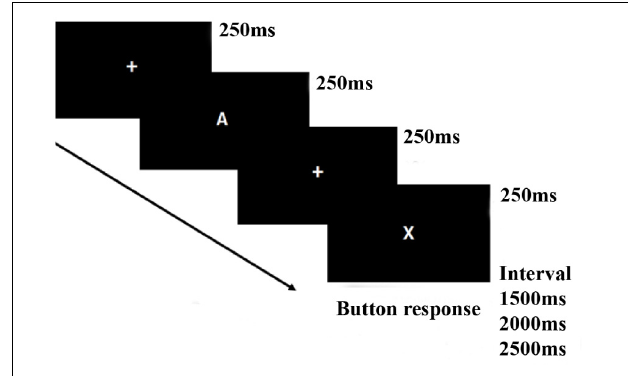
FIGURE 1 | AX-Continuous performance test (AX-CPT) task